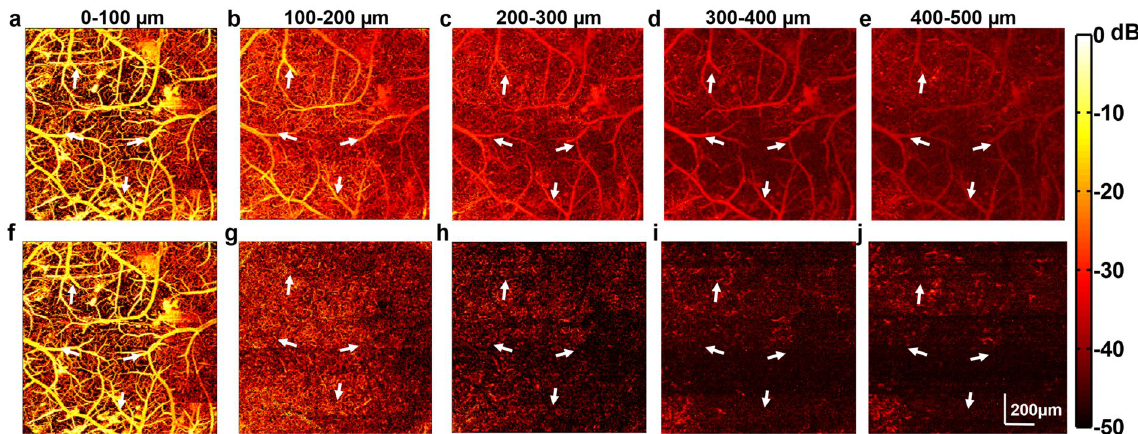
Figure 8. Representative MAP images before and after processing. ( a – e ) show the images before processing with reverberant artifacts denoted by arrows. ( f – j ) show the images after processing. The MAP images were generated using data ± 50 µ m about the focal plane (depth indicated in the figure). The arrows indicate the ghosting artifacts in the MAP images from